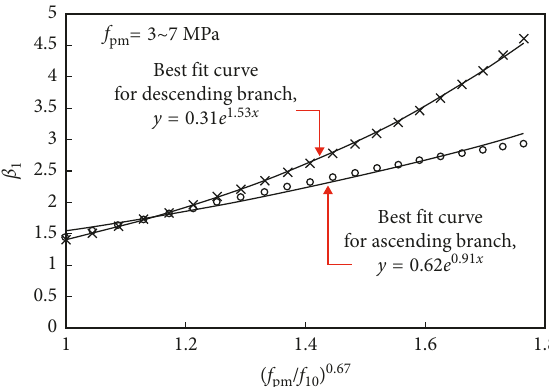
Figure 12: Best-fit equation for key parameter β